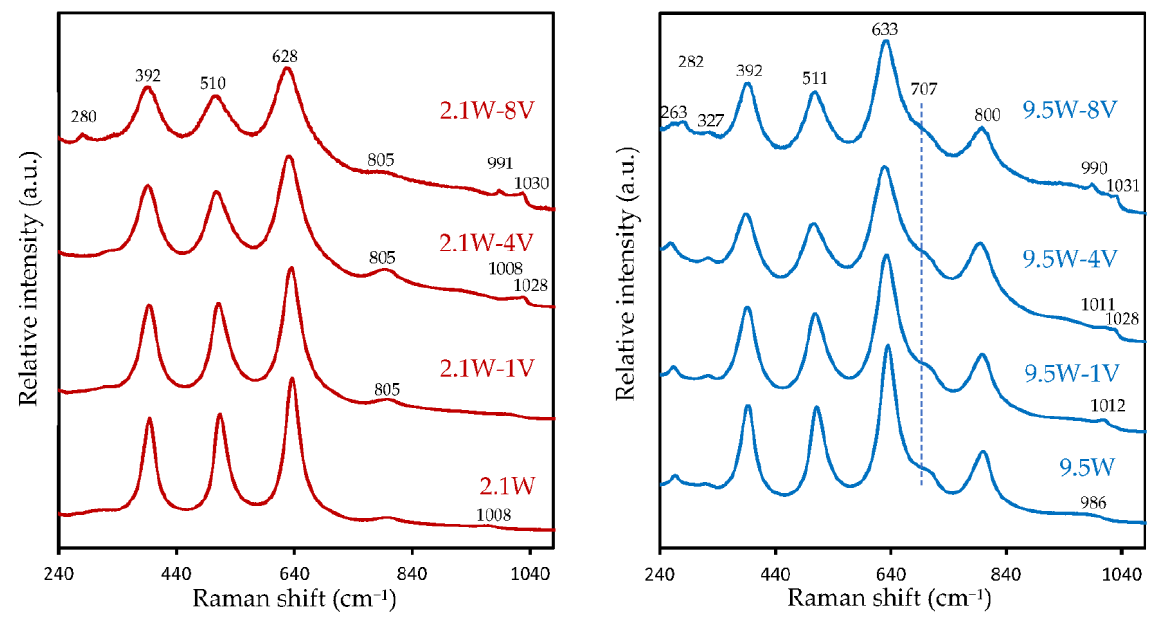
Figure 6. Raman spectra recorded on V 2 O 5 - WO 3 /TiO 2 catalysts calcined in air at 450 °C.